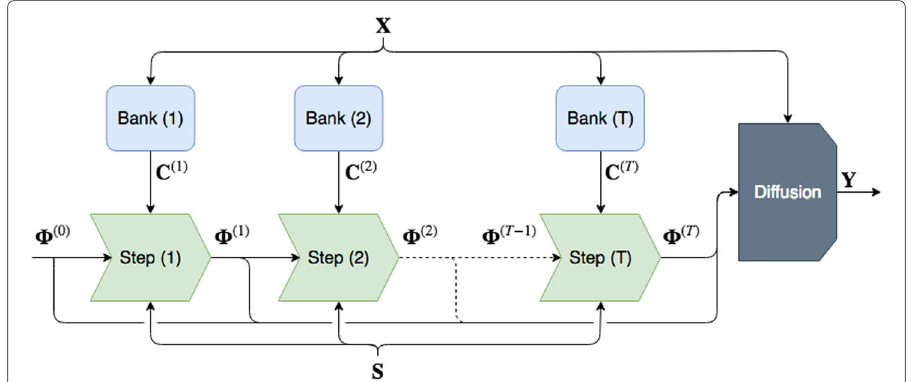
Fig. 2 Quantum walk neural network diagram. The feature matrix X is used by the banks to produce the coin matrices C used in each step layer as well in the final diffusion process. The superposition (cid:5)(cid:5)(cid:5) evolves after each step of the walk. The diffusion layer diffuses X using each superposition { (cid:5)(cid:5)(cid:5) ( 0 ) , (cid:5)(cid:5)(cid:5) ( 1 ) ,... (cid:5)(cid:5)(cid:5) ( T ) } and concatenates the results to produce the output